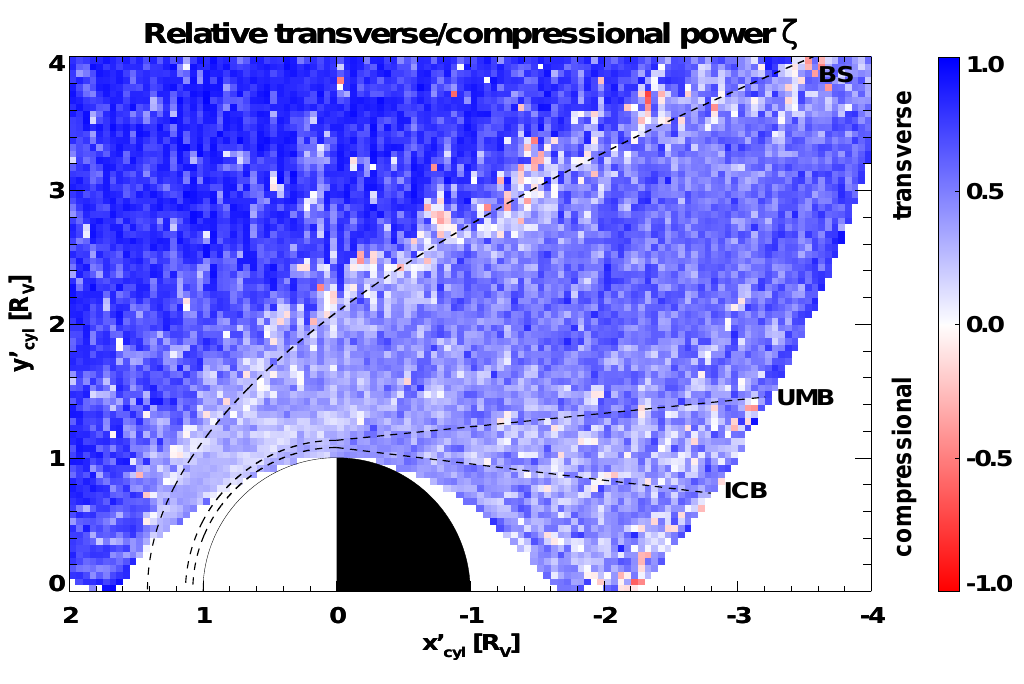
Fig. 4. Difference between the transverse and compressional power normalised to the total power about the mean field. The coordinate system is the same as in Fig. 1. Blue regions indicate regions where the transverse power dominates ( ζ =+ 1 purely transverse) and red regions where the compressional power dominates ( ζ = − 1 purely compressional). In the vicinity of the dayside bow shock the magnitude of transverse and compressional power are of the same size, whereas in the vicinity of the nightside bow shock the compressional portion increases. In the dayside magnetosheath as well as in the mantle and tail region the compressional power is slightly higher than the compressional power in the nightside magnetosheath. In the solar wind upstream of the bow shock the transverse portion of the power dominates over the compressional